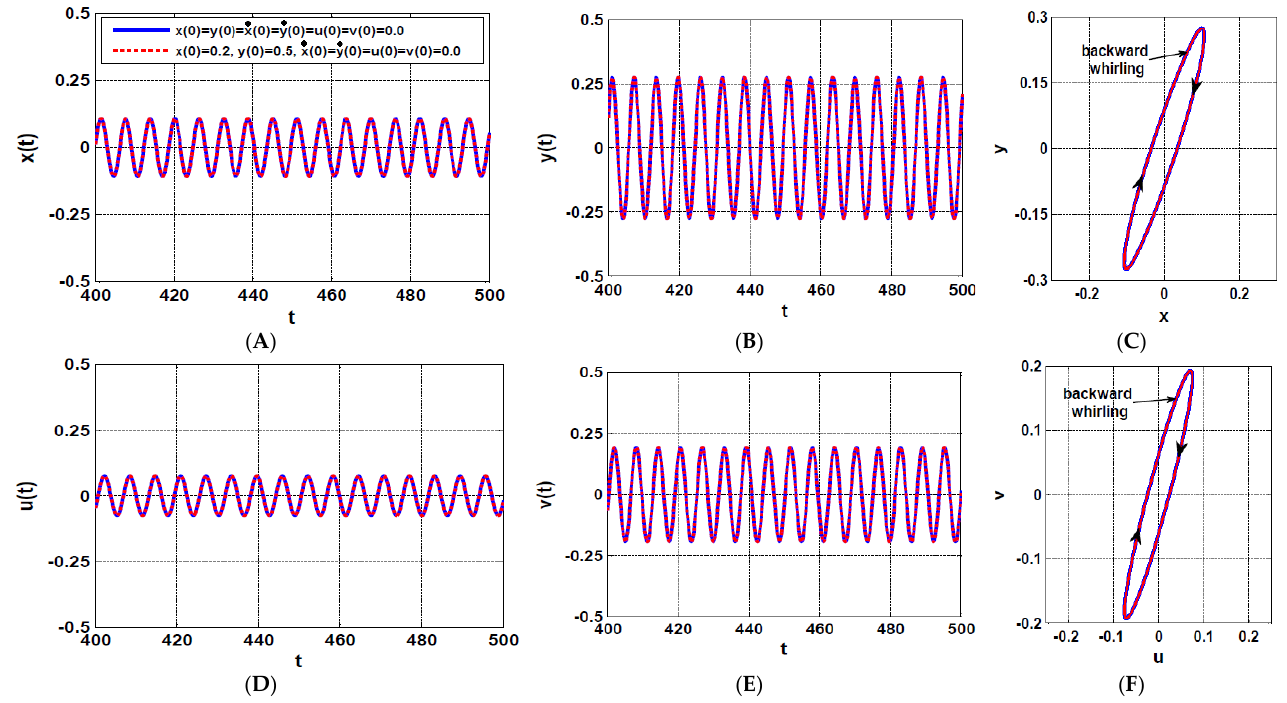
Figure 7. The rotor system steady-state time-response according to Figure 5E,F when 𝜎 = 0 : ( A , B ) temporal oscillation in 𝑋 and 𝑌 directions, respectively, ( D , E ) temporal oscillations of the U-IRC and V-IRC, respectively, ( C , F ) the corresponding periodic orbits.